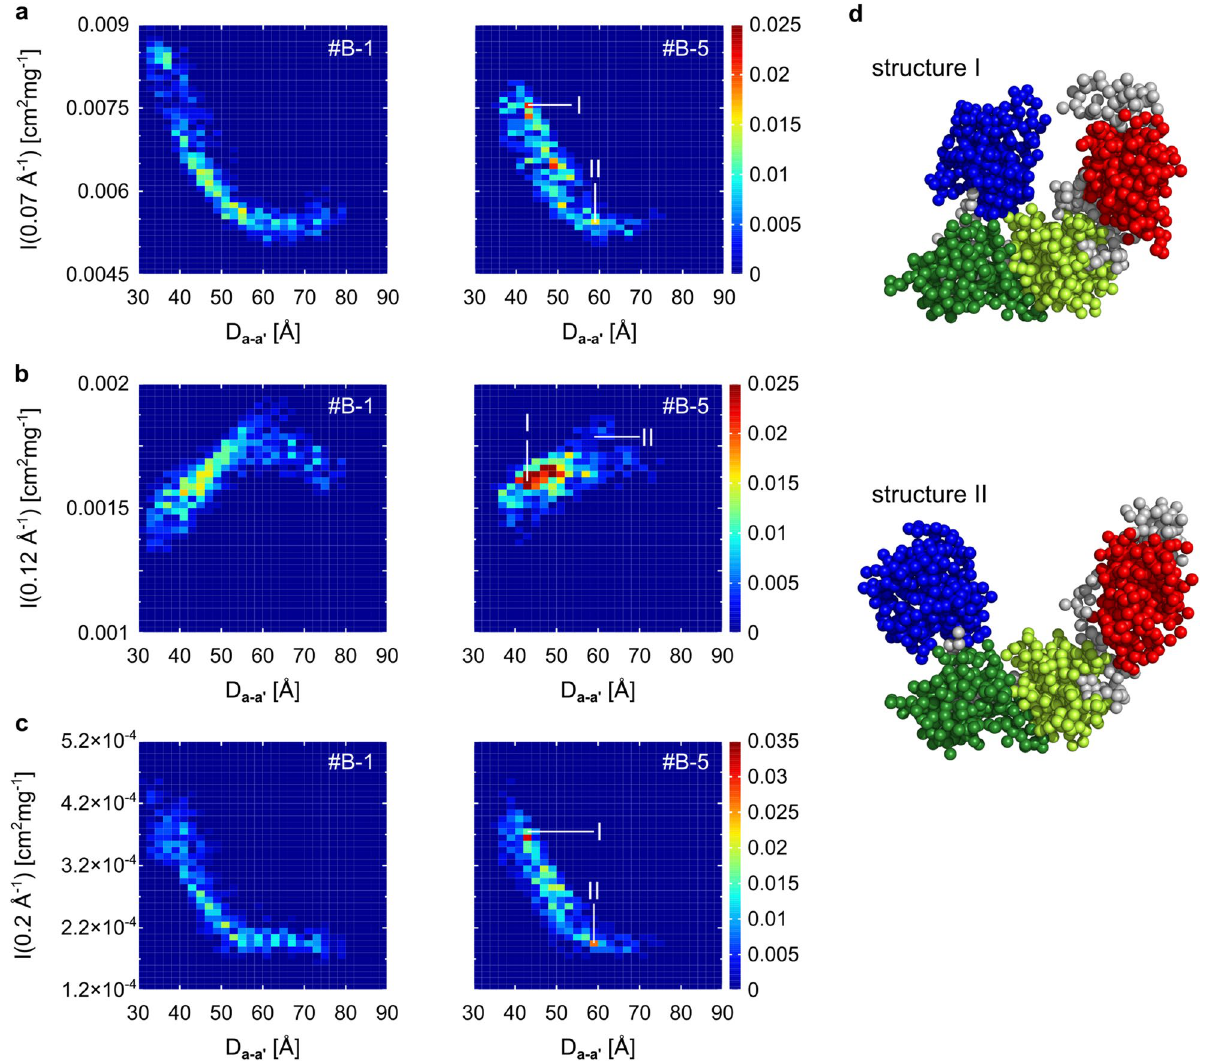
Figure 7. Relationship between I(Q) and domain conformation. a – c Correlation between the distance D a - a ′ and scattering intensity. ( a ) Appearance probabilities of pairs of values the D a - a ′ and I(0.07 Å −1 ). The color shows the probability. ( b ) The probabilities of pairs of values the D a - a ′ and I(0.12 Å −1 ). ( c ) The probabilities of pairs of values the D a - a ′ and I(0.2 Å −1 ). Here, the heatmaps for the time series #B-1 and #B-5 are shown. ( d ) Two typical structures in the #B-5. The a domain in shown in blue, the b domain in green, the b ′ domain in yellowish green, and the a ′ domain in red. The other parts are in gray. In panels a , b , and c , the pixels to which the structure I and II belong are